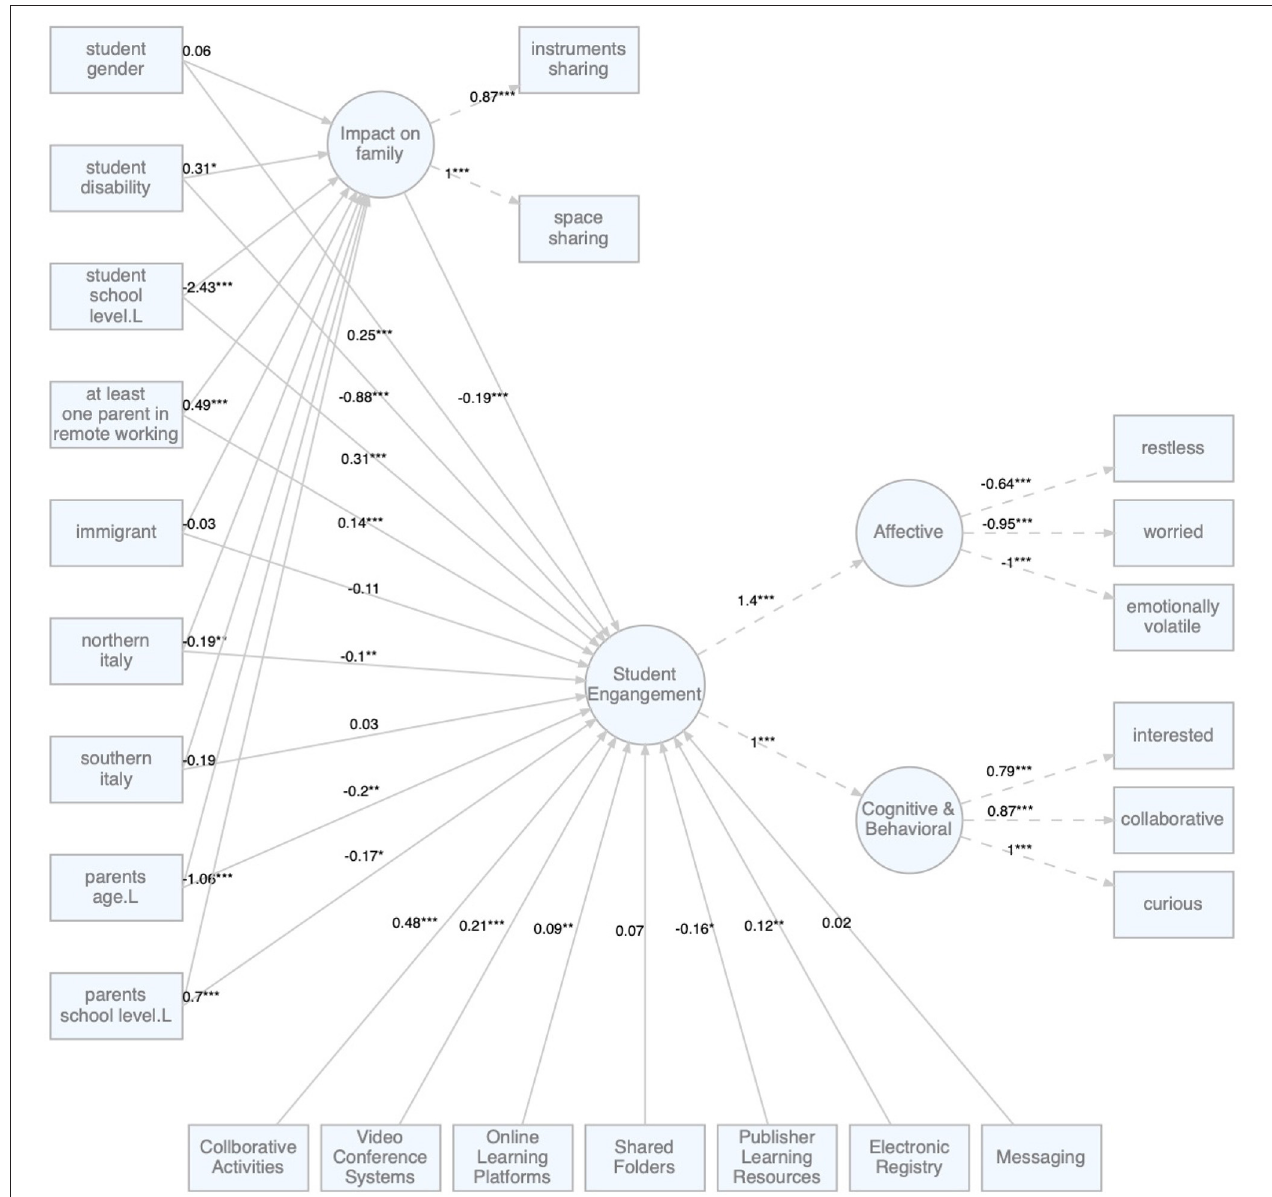
FIGURE 3 | Model B: The role of distance learning family’s impact on students’ engagement. * p < 0.05; ** p < 0.01; *** p <